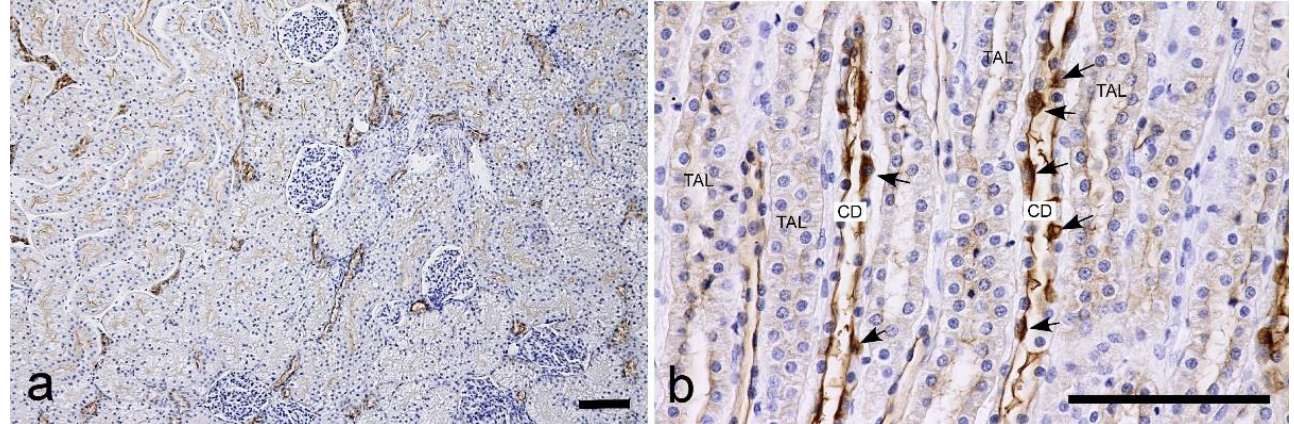
Figure 3. Histochemical staining for succinylated wheat germ agglutin (s-WGA) in the feline kidney. ( a ) Low magnification view of the cortex. The staining intensity of the brush border of the proximal tubules is different between areas within the cortex. ( b ) High magnification view of the inner medulla. TAL: thick ascending limb of the loop of Henle. CD: collecting duct. Arrows: CD cells with positive cytoplasm. Scale bars: 100 μm.